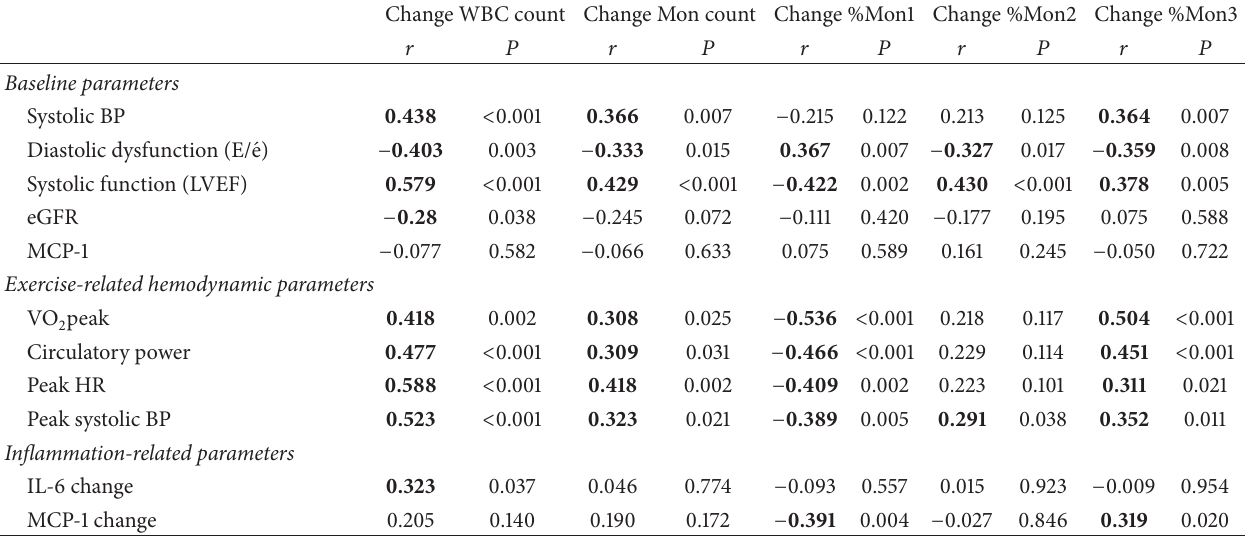
Table 4: Relation of changes in monocyte subsets with baseline, exercise, and inflammation-related